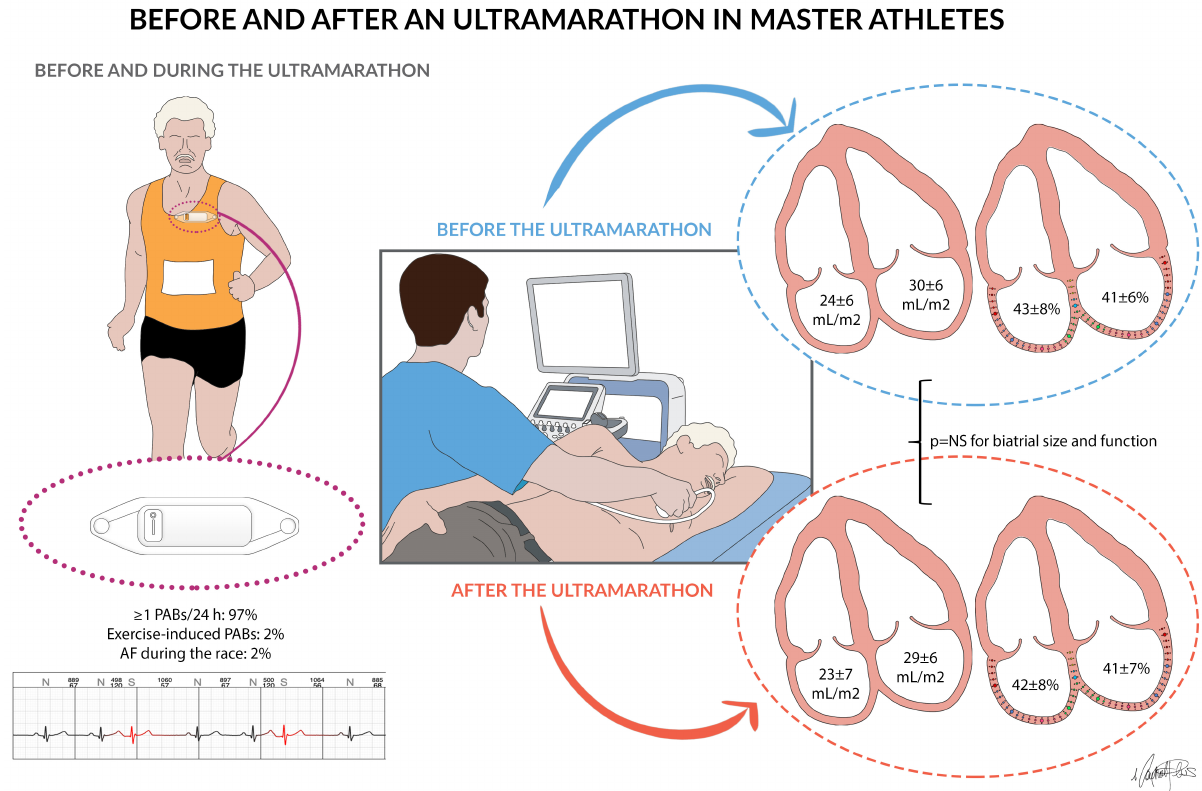
Figure 1. The figure illustrates the main findings of the study: data on supraventricular arrhythmias, atrial size, and function before and after the ultramarathon are